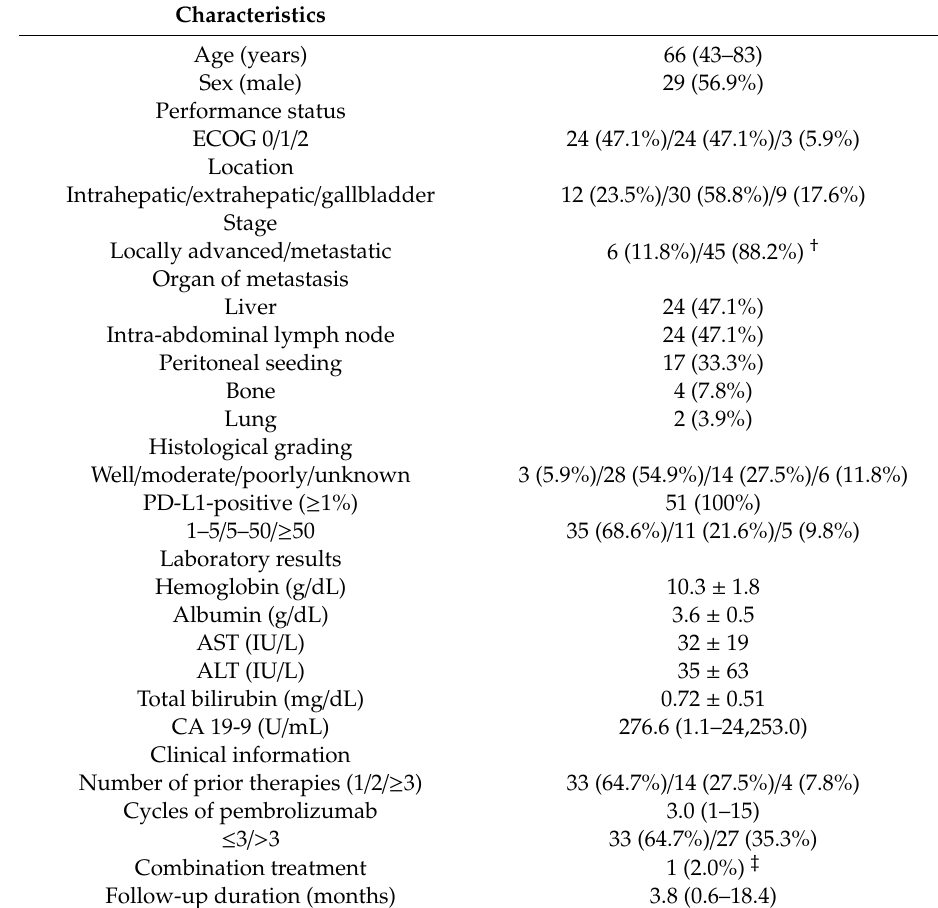
Table 1. Baseline characteristics of